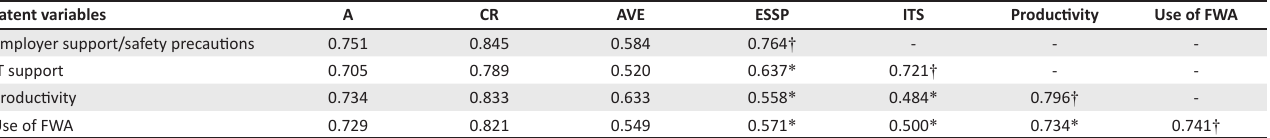
TABLE 1: Validity and reliability of the research instrument. Latent variables